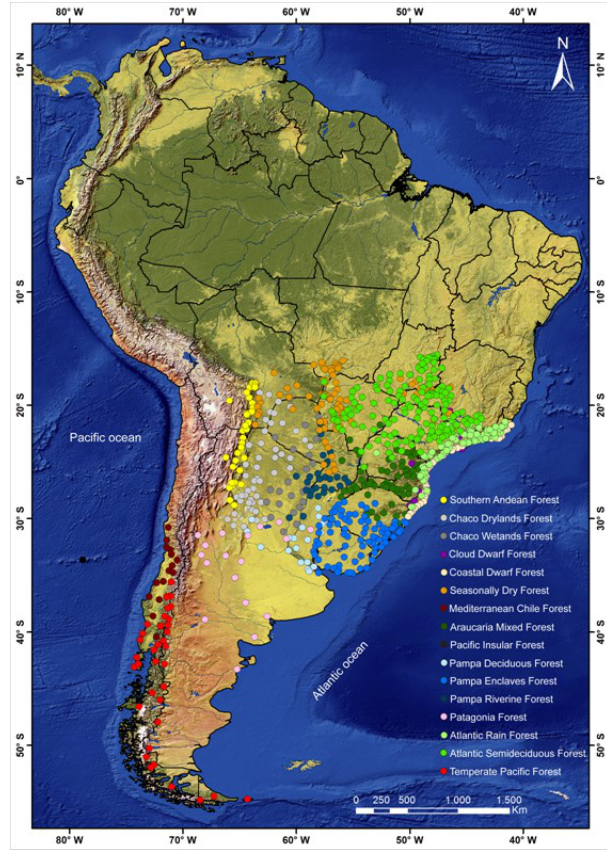
Figure 2. Map showing the location of the 16 vegetation types separated by floristic similarity